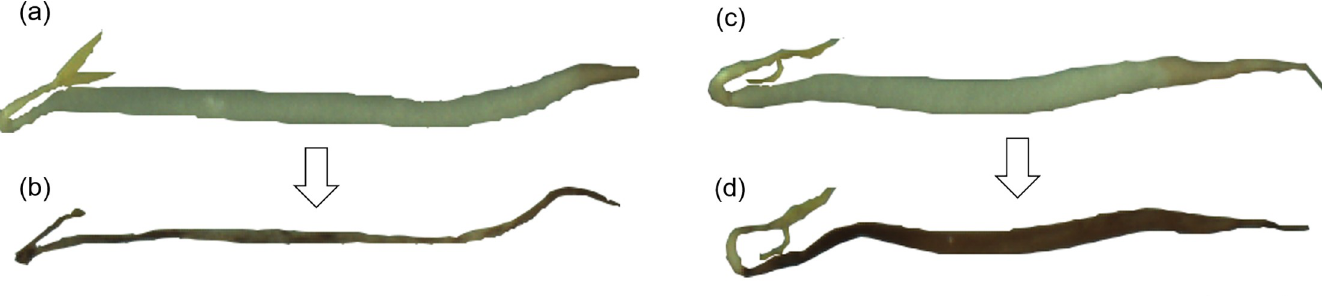
Fig 3. Typical changes in the shape of mung bean sprouts at different gravity levels (scale bar: 10 mm). (a) a sample before the start of storage under normal gravity ): 100%], (b) a sample after storage under normal gravity ( M [mass retention rate ( M r 100%), (d) a sample after storage under simulated microgravity ( M r : 17.8%).